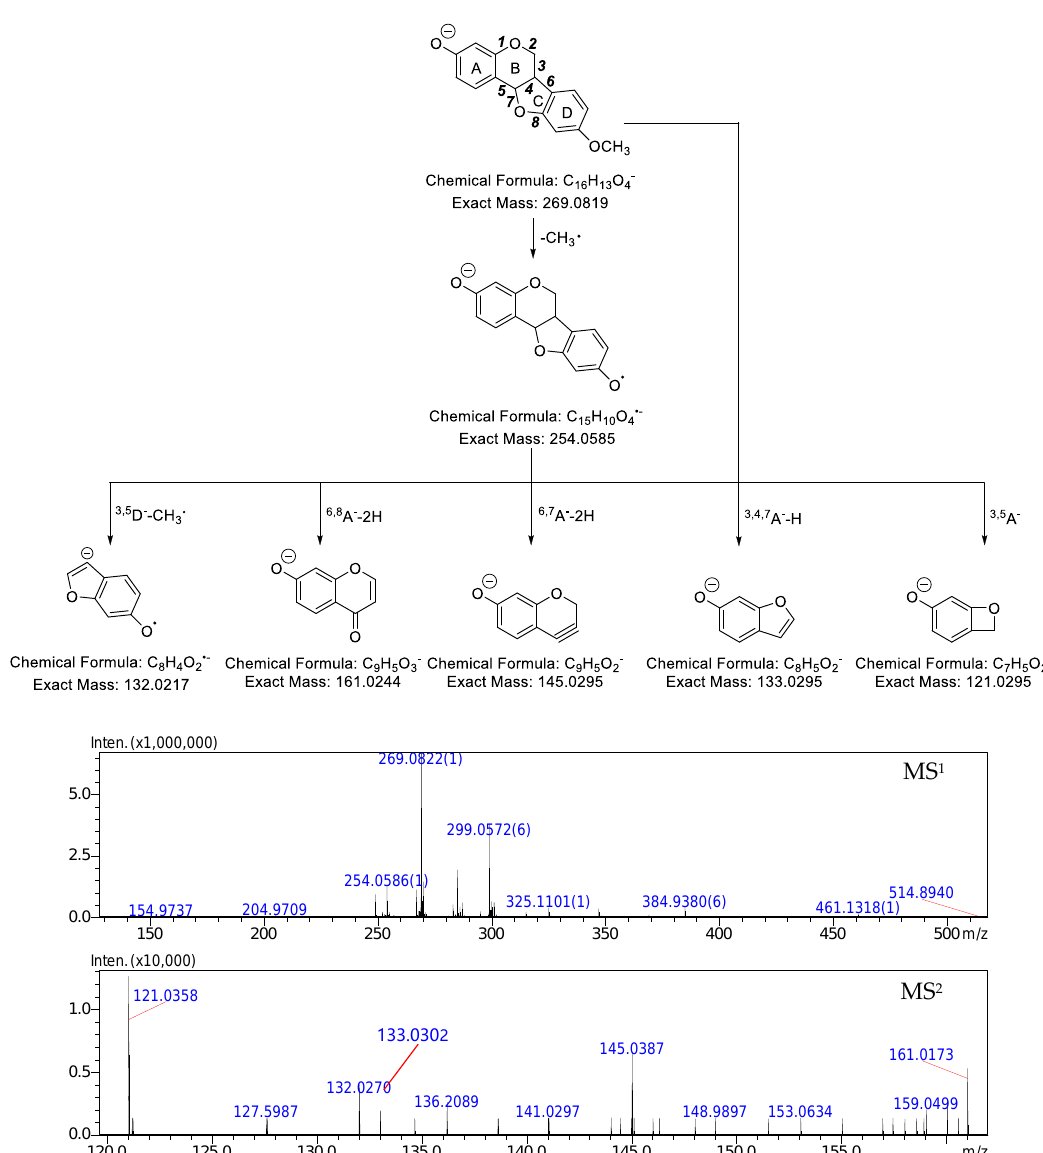
Figure 2. The MS spectra and the proposed fragmentation pathways of medicarpin in ESI− mode.